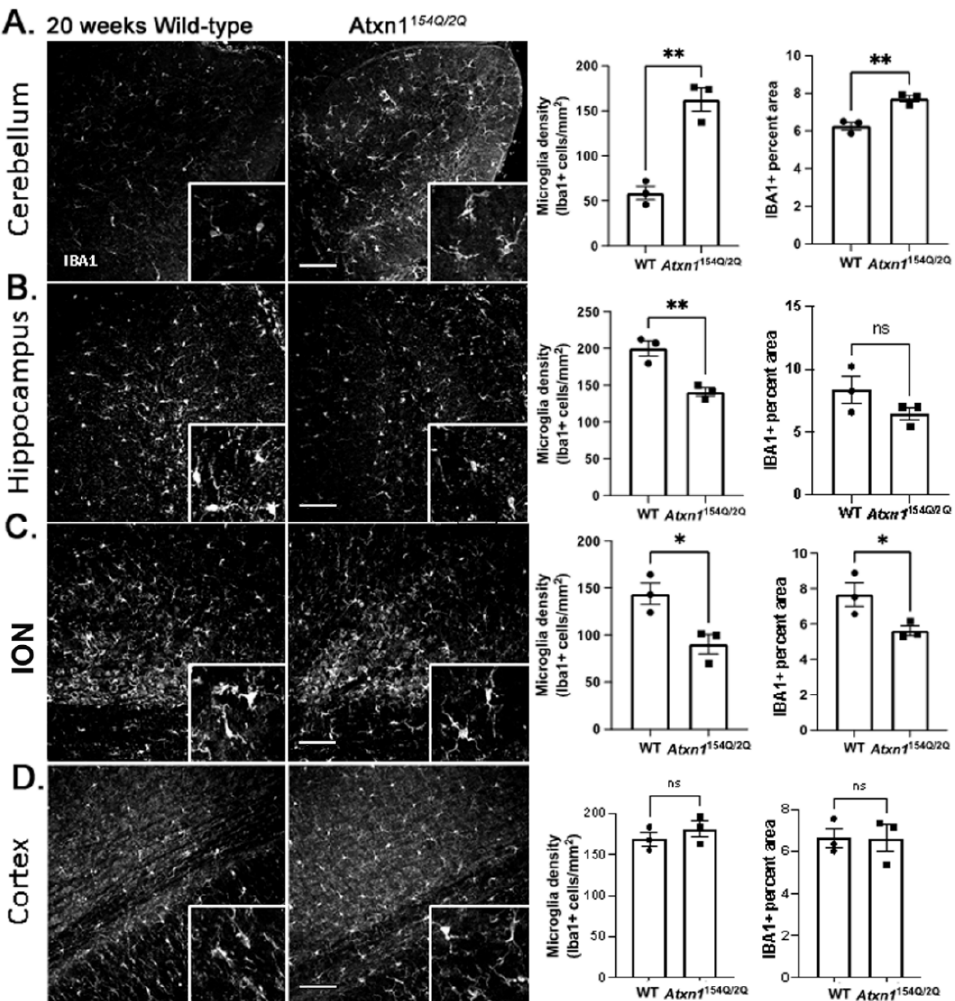
Figure 6. Diversity of late SCA1 microglial morphology phenotypes in Atxn1 154Q/2Q mice. Brain sections from 20 weeks old Atxn1 154Q/2Q and wild-type littermate controls (N = 3–5) were stained for Iba1. Confocal images of cerebellum (( A ), lobule X), hippocampus (( B ), dentate gyrus), brainstem (( C ), ION), and motor cortex (( D ), layer 6 and corpus callosum) were used to quantify density of Iba1-positive microglia and Iba1 area. Images were acquired at 20 × (636.16 µ m × 636.16 µ m). Scale bars show 100 µ m. Insets in the lower right corners of each image show zoomed images (79.5 µ m × 79.5 µ m) for qualitative assessment of microglia morphology. Data are presented as mean ± SEM with average values for each mouse represented by a dot. N = 3–5 mice of each genotype (WT and Atxn1 154Q/2Q ). ns: not significant, * p < 0.05, ** p < 0.01. Students t -test.